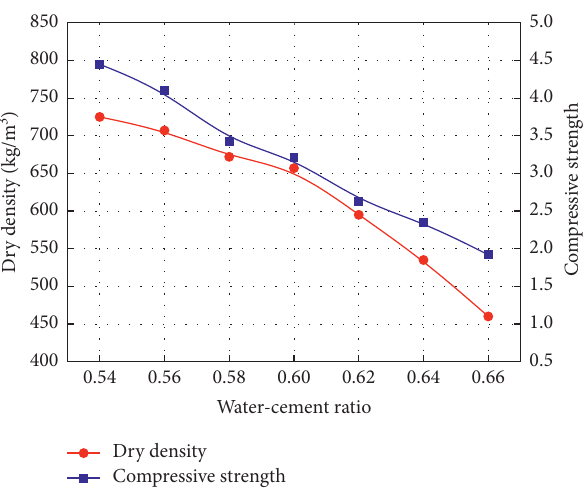
Figure 15: Dry density and compressive strength of foamed concrete under different water-cement